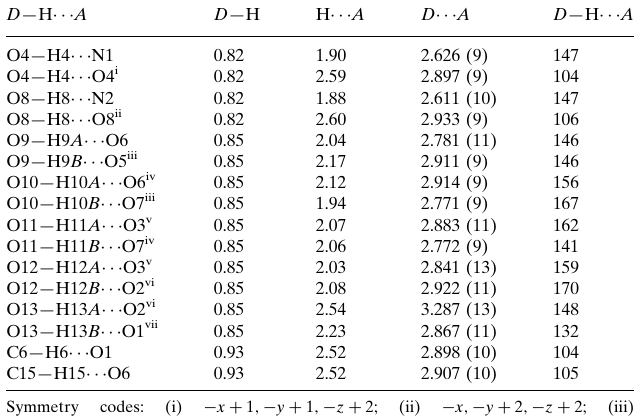
Hydrogen-bond geometry (A˚ , (cid:2)